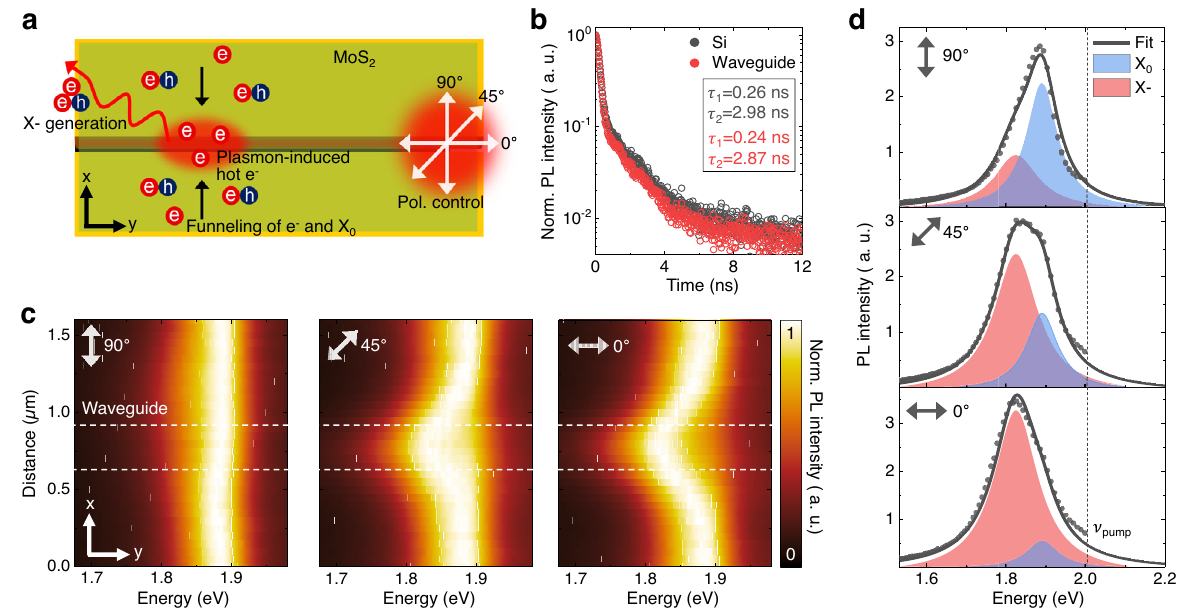
Fig. 3 | Complete exciton-to-trion conversion. a Illustration of exciton-to-trion conversionprocessassistedbyplasmon-inducedhotelectrons. b NormalizedTRPL tracesofMoS 2 monolayeronsilicon(black)andwaveguidestructure(red). c Spatial